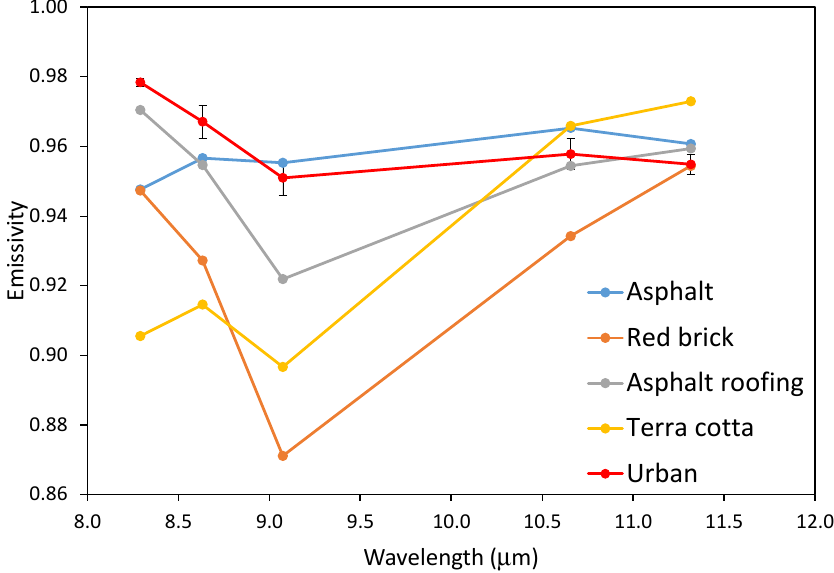
Figure 12. Mean emissivity of urban construction materials retrieved from the ASTER Spectral Library and integrated for the five thermal ASTER bands.